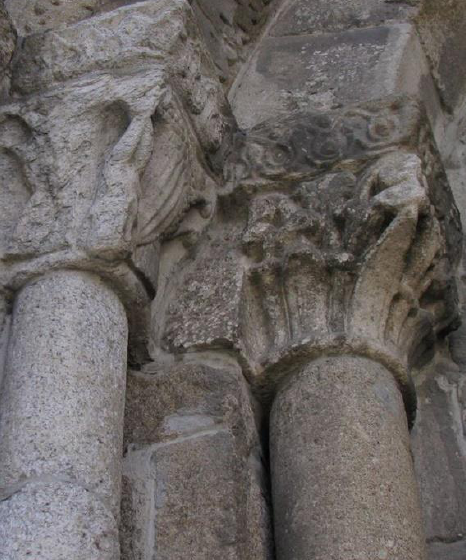
Figure 5. Image of two granite types on columns of a portal in a monument of Braga (NW Portugal): the darkish- brownish one on the right is similar to the local granite while the lighter one on the left is similar to certain facies from surrounding